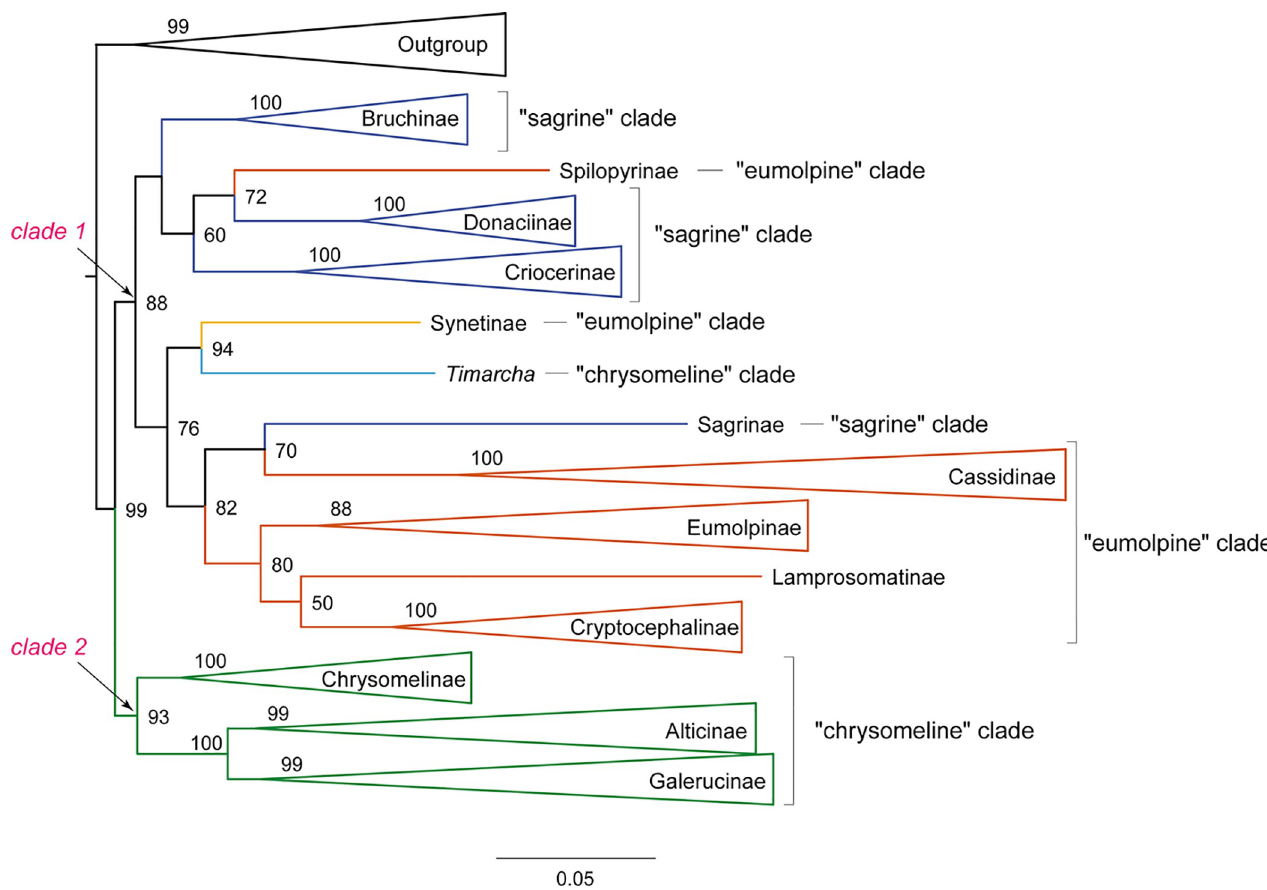
Fig 3. ML tree inferred from the dataset PCGaa_Dayhoff using IQ-TREE under the MK+FQ+I+G4 model. Lineages have been collapsed for clarity. The lengths of the triangles correspond to the longest terminal branches in the collapsed lineages. Node numbers show the bootstrap support values. The full tree with all branches is available in S1